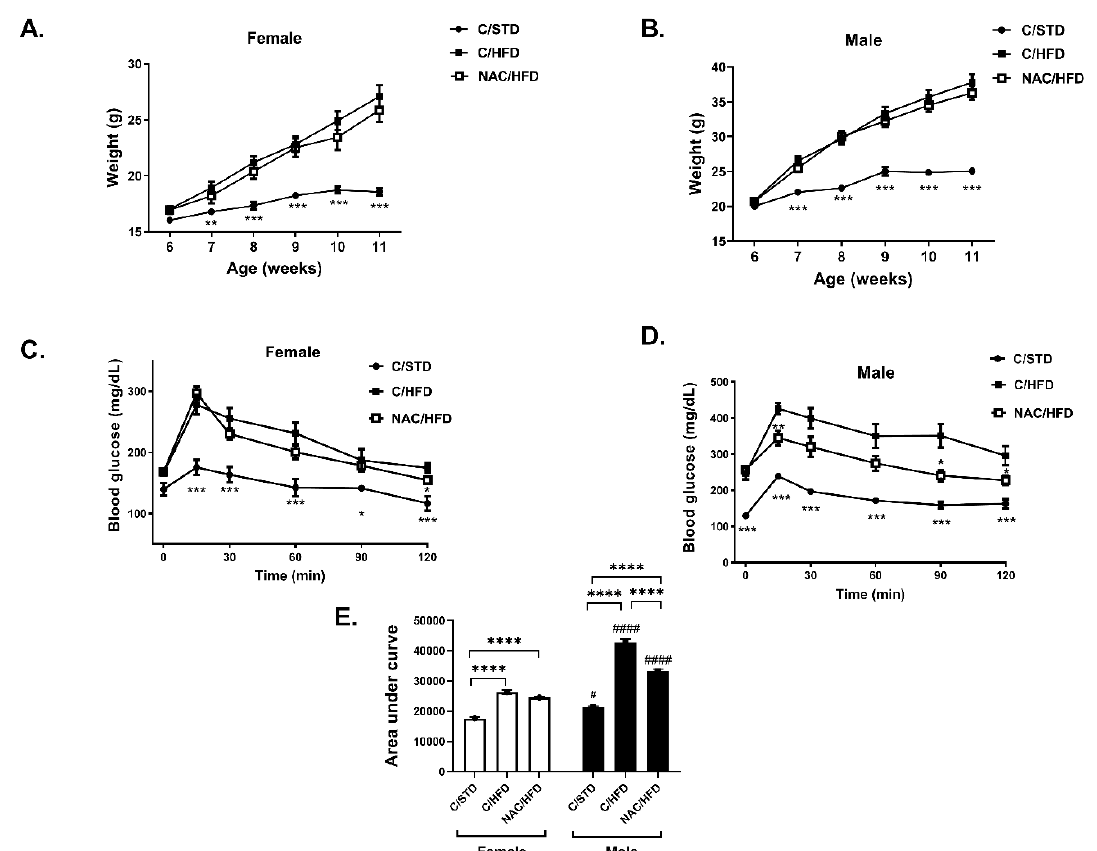
Figure 1. N -acetyl cysteine (NAC) improved glucose tolerance in high fat diet (HFD)-fed o ff spring of NAC-treated male mice. NAC was given to female mice during pregnancy and lactation. HFD was given to o ff spring from the age of 6 weeks. Body weight of female ( A ) and male ( B ) o ff spring was measured every week. Glucose tolerance test (GTT) was performed at age of 14 weeks in female ( C ) and male ( D ) o ff spring as described in Materials and Methods. The results are presented as mean ± SE, * p < 0.05. ** p < 0.005, *** p < 0.0005 compared to C / HFD mice, by one-way ( A , C ) or two-way ( C , D ) Anova. ( E ) Area under curve was calculated using GraphPad Prism 8. C / STD: STD-fed o ff spring of control mice, C / HFD: HFD-fed o ff spring of control mice, NAC / HFD: HFD-fed o ff spring of NAC-treated mice. The results are presented as mean ± SE ( n = 8), **** p < 0.0001, # p < 0.05 and # p < 0.05, #### p < 0.0001 between genders, by two-way Anova followed by Tukey’s post-test. An insulin tolerance test demonstrated a disturbed insulin sensitivity in HFD-fed mice, with males found to be more insulin resistant than females (Figure 2A–D). Insulin resistance was improved in female NAC / HFD mice, and almost completely normalized in NAC / HFD males.